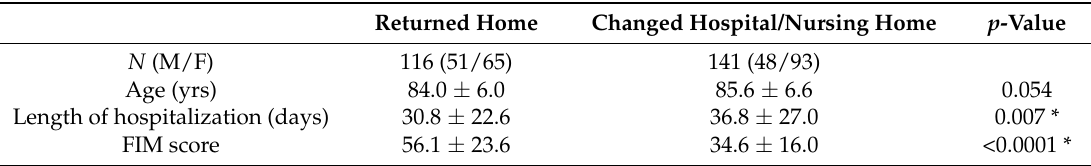
Table 1. Patients characteristics.